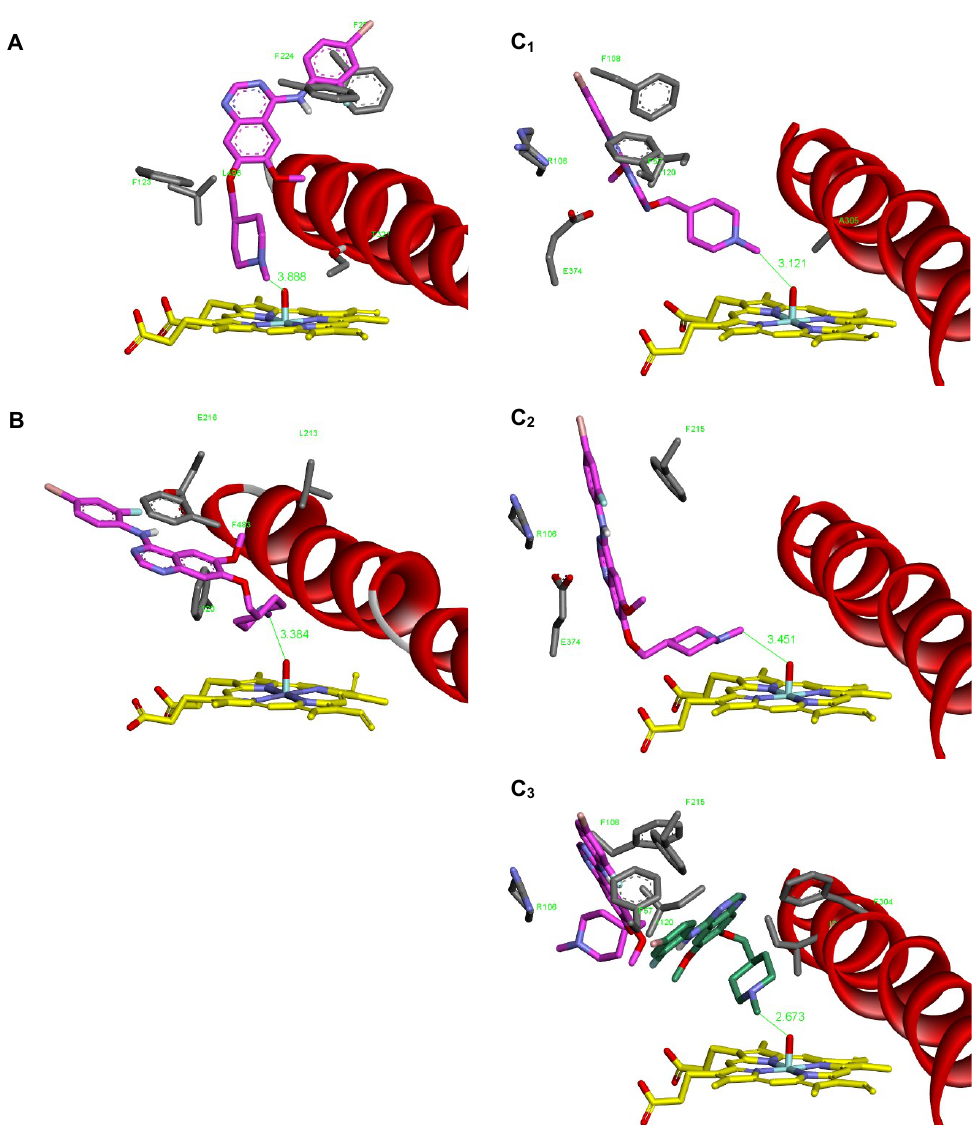
Figure 7. The binding orientations found in molecular docking calculations facilitating oxidative demethylation of N -methyl group of vandetanib in human CYP1A1, CYP2D6 and CYP3A4 represented by X-ray structures CYP1A1 4I8V ( A ), CYP2D6 3tda ( B ), CYP3A4 1W0E ( C 1 ); CYP3A4 6BD7 ( C 2 ); and CYP3A4 6BD7 containing second vandetanib molecule (green) ( C 3 ). Vandetanib molecule (pink/green) and heme (yellow) residues are rendered as bold sticks. Side-chains of amino acid residues closely interacting with vandetanib are shown in gray. Red ribbon represents a part of helix I.